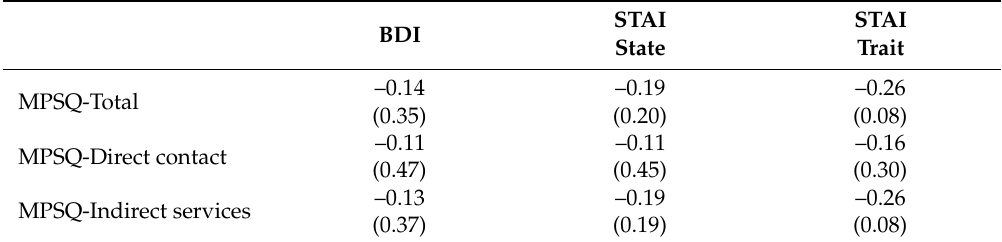
Table 2. Correlations ( p values) between Medical Patient Satisfaction Questionnaire (MPSQ) scores and those obtained on the Beck Depression Inventory (BDI) and State–Trait Anxiety Inventory (STAI).